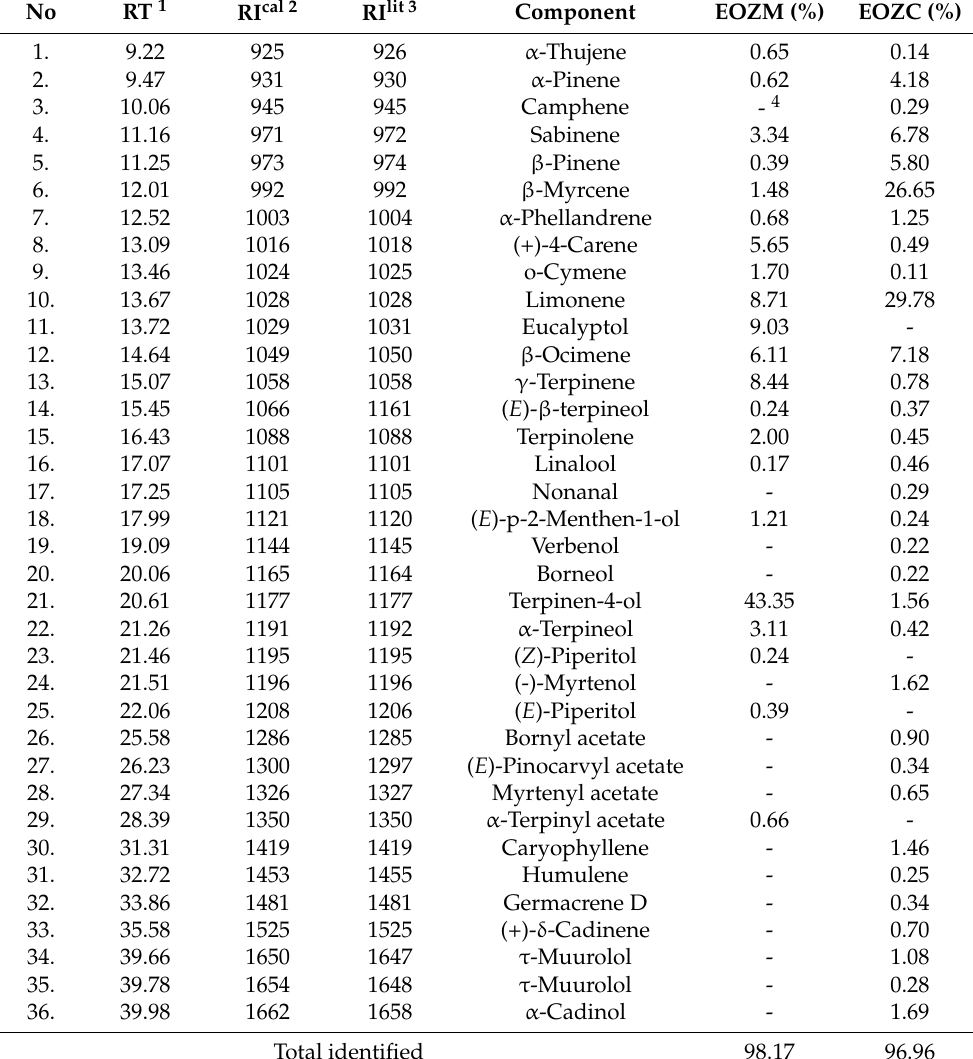
Table 1. Chemical composition of essential oils from Z. acanthopodium